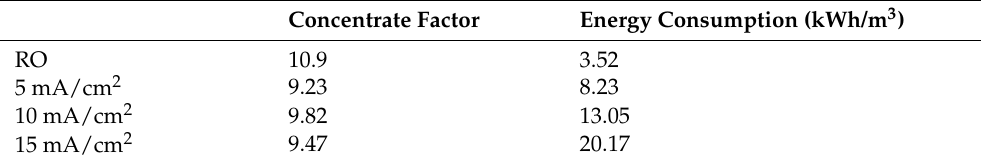
Table 5. Energy consumption and concentration factor of RO and first-stage ED